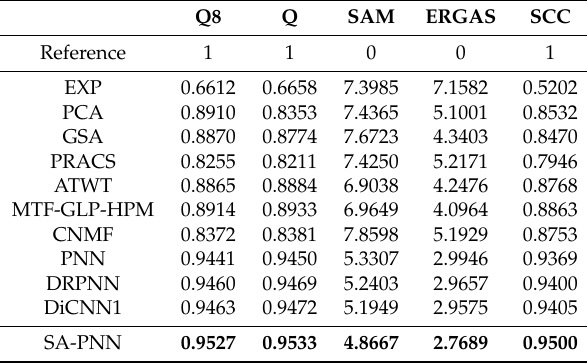
Table 2. Quality indexes at reduced resolution on a 256 × 256 sub-scene of the WorldView-2 dataset (best result is in